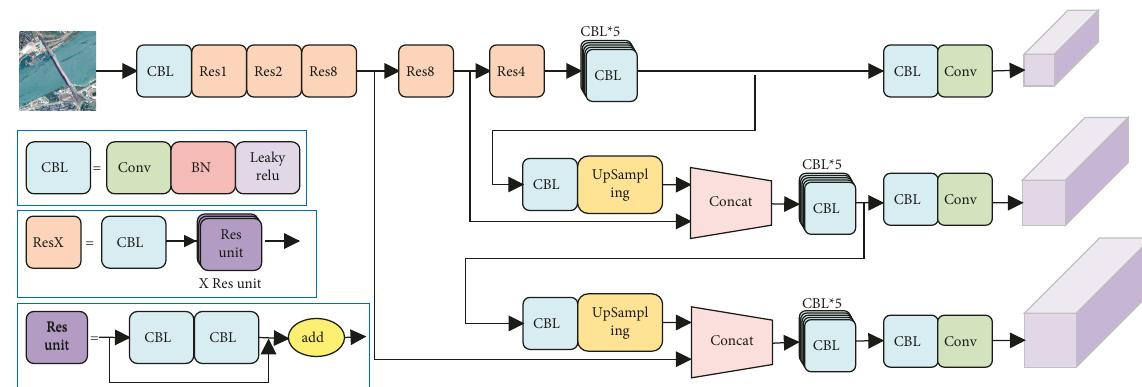
Figure 2: The architecture of YOLOv3